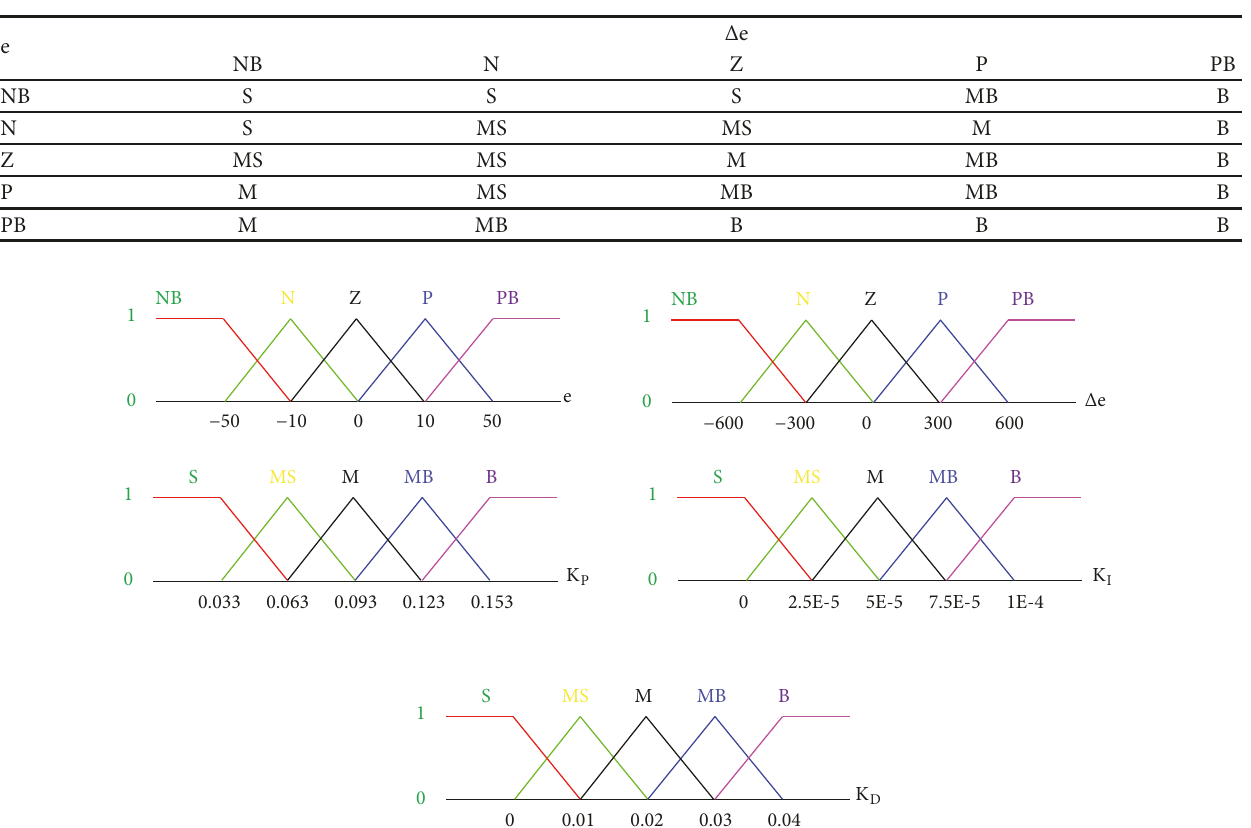
Table 4: Fuzzy rules of K D gain.